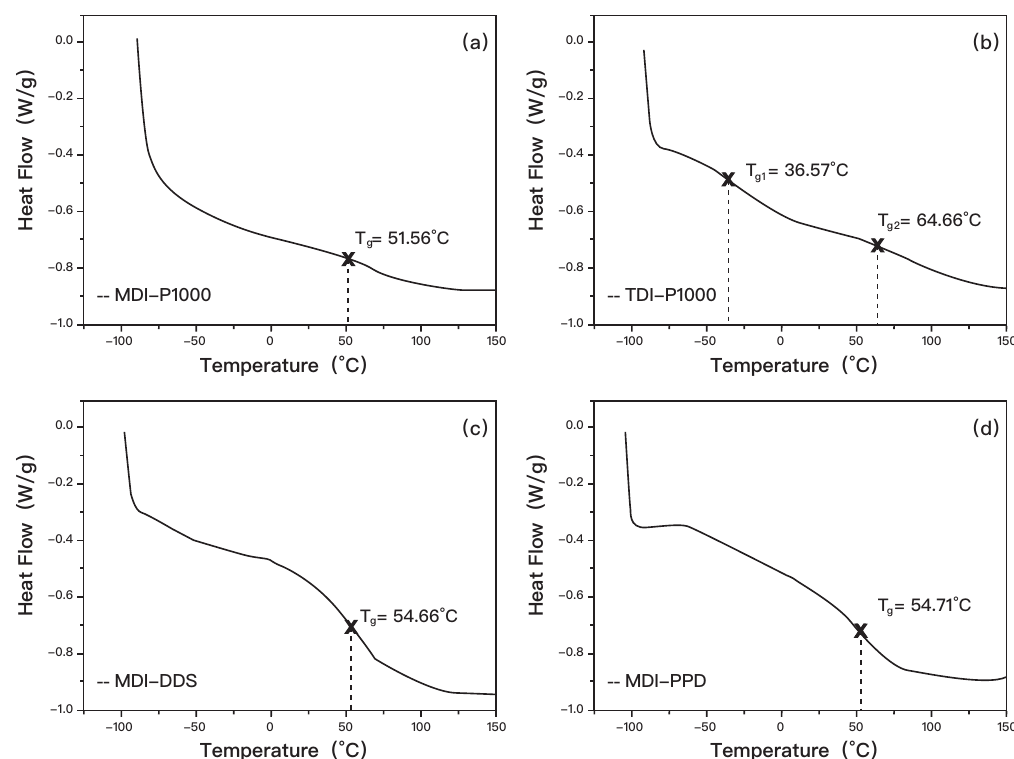
Figure 4. DSC results of ( a ) MDI-P1000, ( b ) MDI-P1000, ( c ) MDI-D2000, and ( d ) MDI-PPD. From the DSC result of TDI-P1000 (Figure 4b), it can be seen that the glass transition temperature is also not distinctive. Similar to MDI-P1000, a molecular weight of TDI is also much lower than that of P1000. Hence, the sample could also be a gradient copolymer. Upon further zooming in at the locations selected, there are two transition temperatures found in the result [42]. One glass transition temperature could be determined as − 36.57 ◦ C and the other as 64.66 ◦